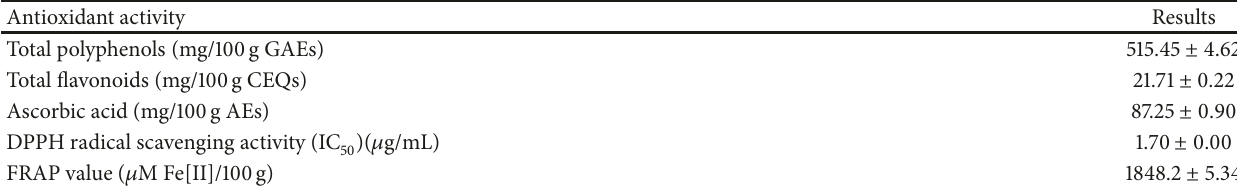
Table 1: Polyphenol, flavonoid, and ascorbic acid contents as well as DPPH radical scavenging activity and FRAP values for pomelo methanolic extract.